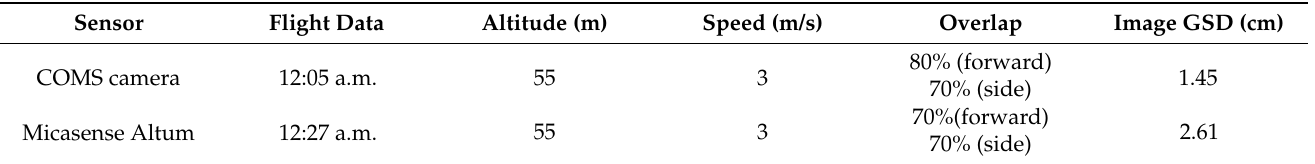
Table 1. UAV image acquisition